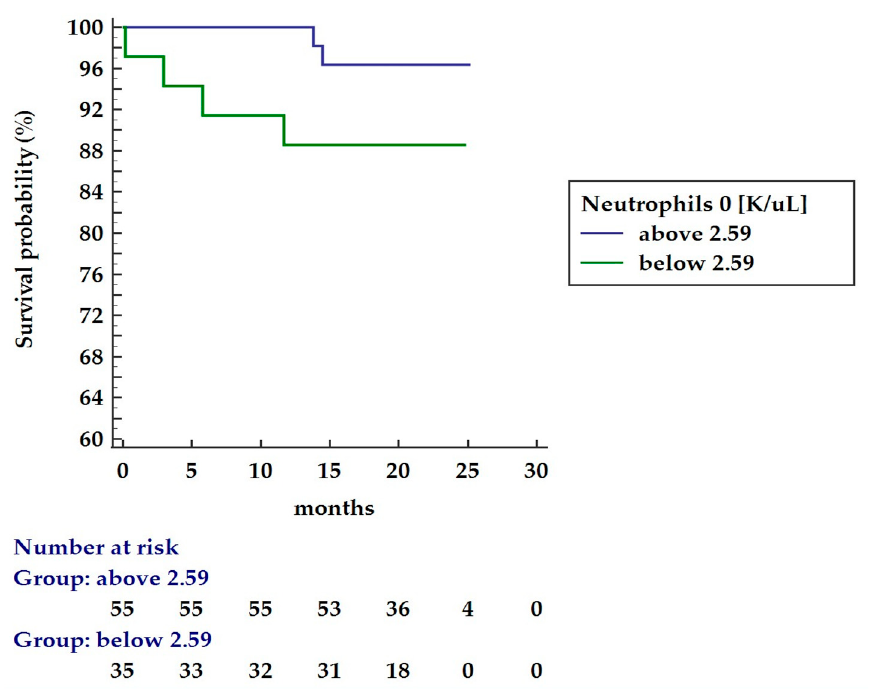
Figure 3. Kaplan–Meier 30 months survival analysis for patients’ cohort based on lower (green) and upper (blue) cut-off (2.59 K/uL) of the neutrophil count.